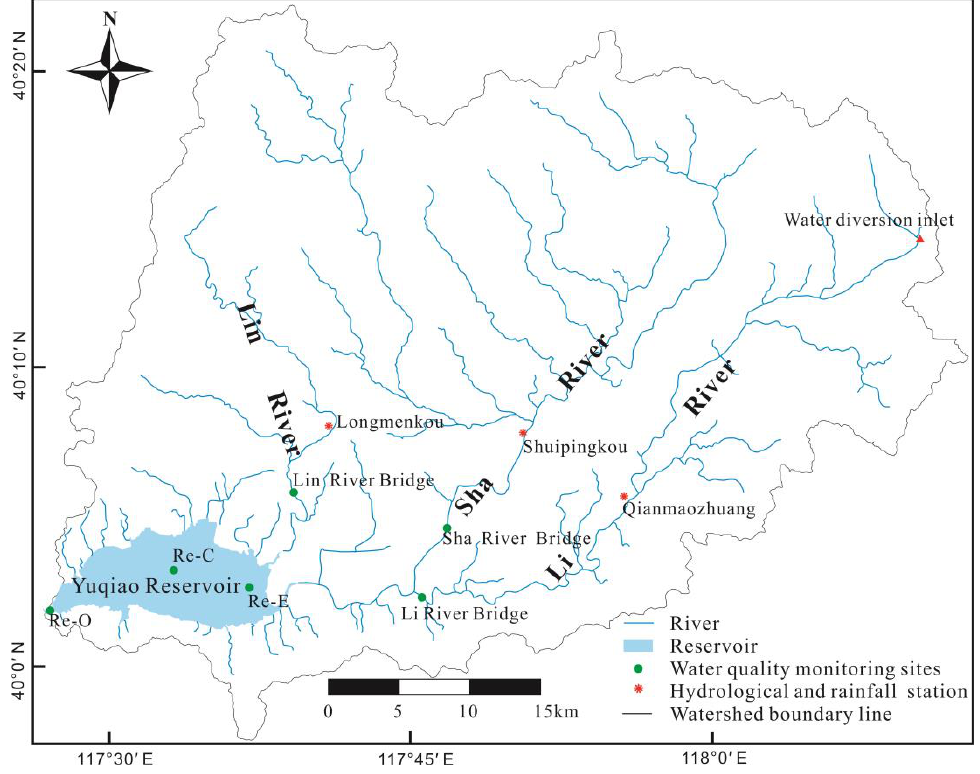
Figure 1. The location of hydrological stations and water monitoring sites in the Yuqiao Reservoir watershed. Re-E, Re-C, and Re-O represent the east, center, and outlet of the reservoir.